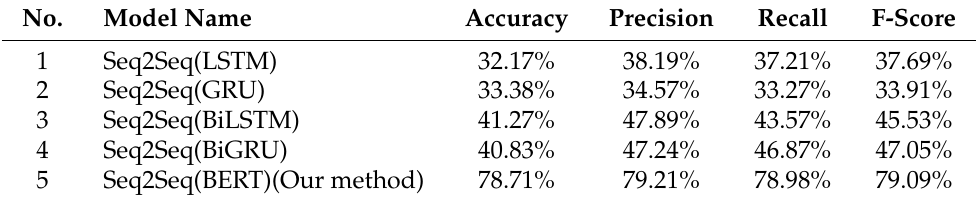
Table 9. Experimental comparison results of the language